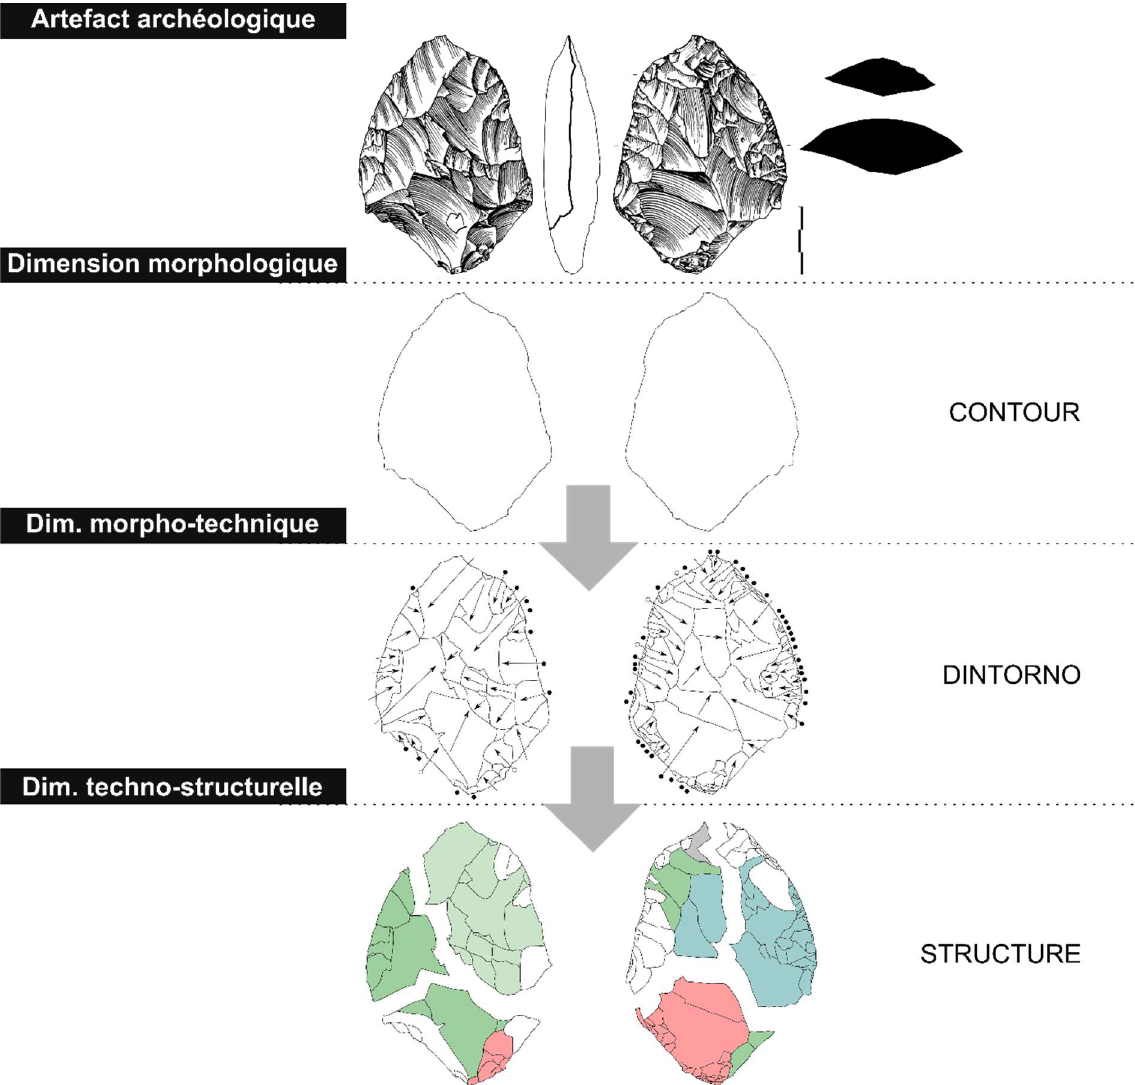
Figure 4. Exemple des différentes dimensions analytiques d'un artefact selon l'approche utilisée. Ce que nous appelons artefact correspond à l'objet immédiatement retrouvé lors des fouilles archéologiques. La typologie morphologique favorise une analyse du contour de la pièce. Bien souvent cette analyse nous offre des informations pertinentes, mais il faut tenir compte du fait que le contour (ou ce que l'on appelle généralement forme) n'est qu'un des critères techniques qui composent la structure de la pièce lithique. La technologie, quant à elle, privilégie l'étude de la production de l'artefact, c'est-à-dire de son dintorno , des processus de production contenus dans son contour et qui lui ont donné forme. Finalement, la technologie fonctionnelle part de l'analyse du dintorno pour identifier la structure de l'artefact, les zones fonctionnelles qui permettent son fonctionnement